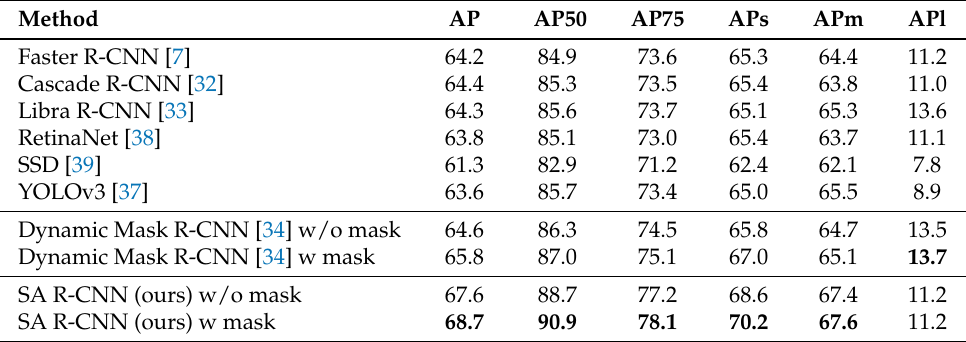
Table 5. Ablation for the mask branch’s contribution to the ship detection